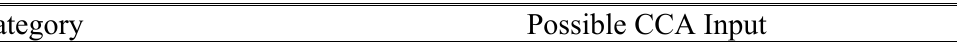
Table A2.1. Possible inputs used for non-numerical variables in canonical correspondence